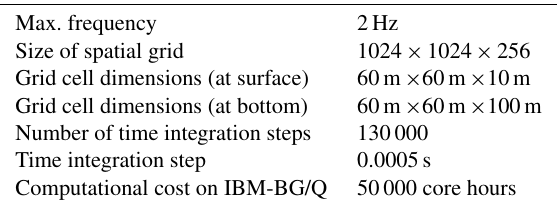
Table 2. Parameters defining the performed 3-D numerical simula-